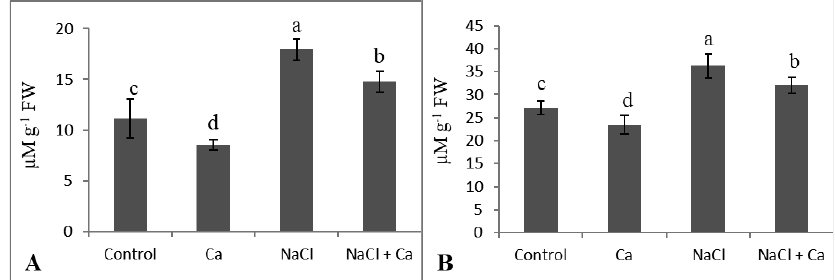
Fig. 4: Effect of salinity stress (100 mM NaCl) on (A) hydrogen peroxide and (B) lipid peroxidation (MDA) in soybean ( Glycine max L.) with and without calcium supplementation. Data is mean (±SE) of three replicates and bars with different letters denote significant difference at P ≤